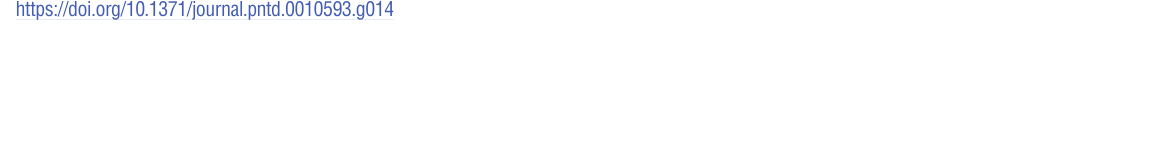
Fig 14. Heatmaps of the results of post-hoc multiplicity adjusted tests following a linear mixed model of the EPG at post treatment in studies of 14–21 days Follow-up: A. A . lumbricoides , B. T . trichiura , C. hookworm.